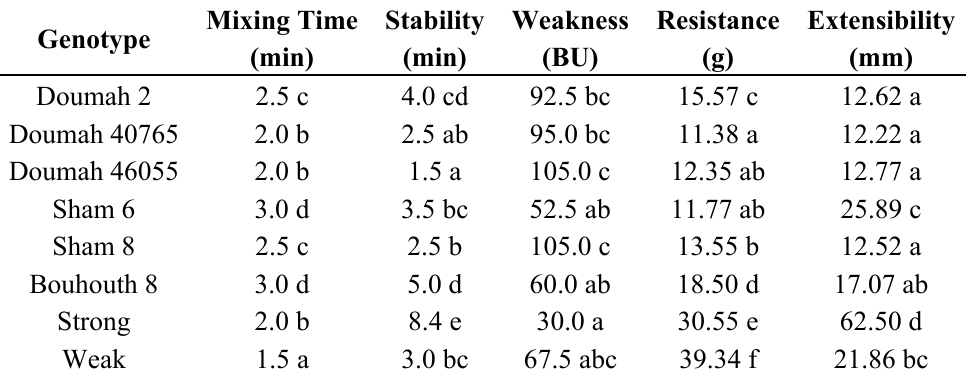
Table 7. Characteristics of the dough samples.